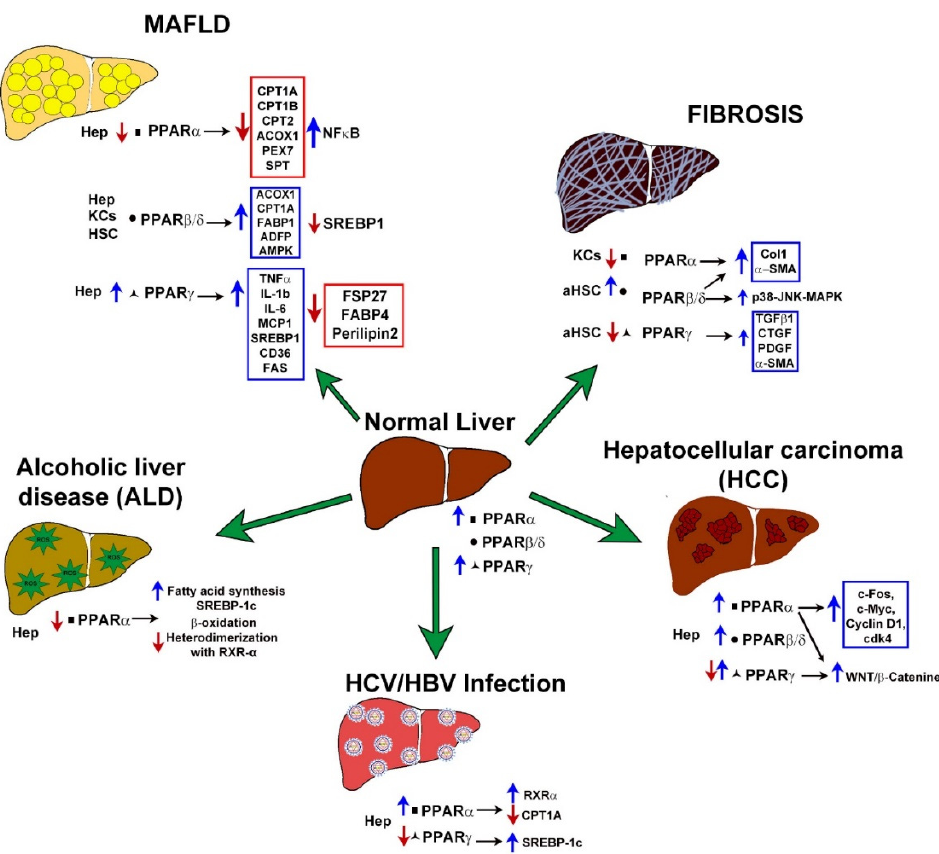
Figure 3. Main molecular targets regulated by PPARs in liver diseases addressed in this review: metabolism-associated fatty liver disease (MAFLD), alcoholic liver disease (ALD), fibrosis, HBV viral hepatitis or HCV infection and hepatocellular carcinoma (HCC). Blue arrows indicate over-activation, while red arrows indicate downregulation of triggered responses. Hep, hepatocytes; KCs, Kupffer Cells; HSCs, Hepatic Stellate Cells. Table 2. Role of PPARs in liver diseases.